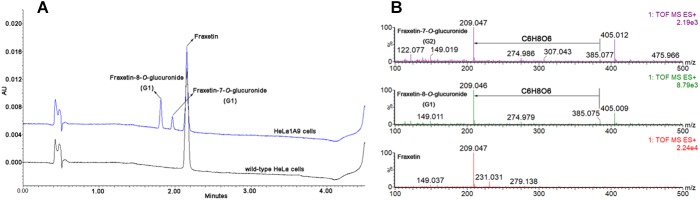
Ultra-high-performance liquid chromatography chromatograms and mass spectra of fraxetin and its related glucuronides. (A) UHPLC chromatograms of fraxetin, fraxetin-8-O-glucuronide (G1), and fraxetin-7-O-glucuronide (G2) generated in wild-type HeLa cells and HeLa1A9 cells. (B) electrospray ionization (ESI) mass spectra of fraxetin, G1, and G2 in positive ion mode.